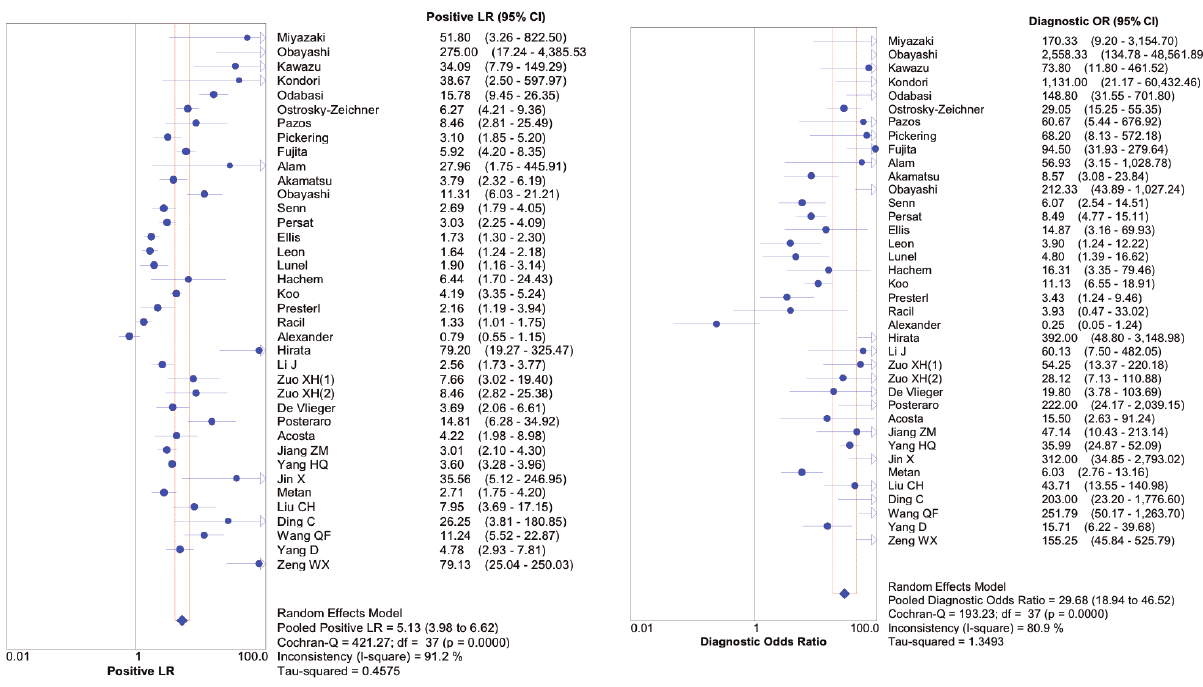
Figure 7: Pooled forest plot of dor for 1,3-β-D-glucan in diagnosis of invasive fungal infection